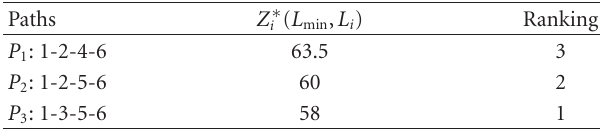
Table 5: Results of the network based on signed distance ranking index.